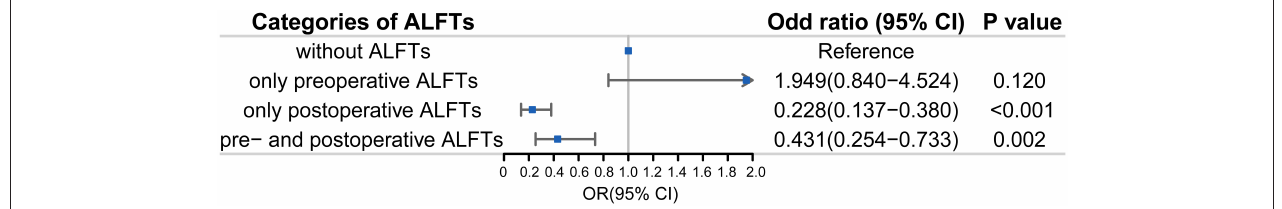
FIGURE 4 | Association between ALFTs at different periods and the favorable prognosis in patients with AIS. ALFT, abnormal liver function; OR, odds ratio.